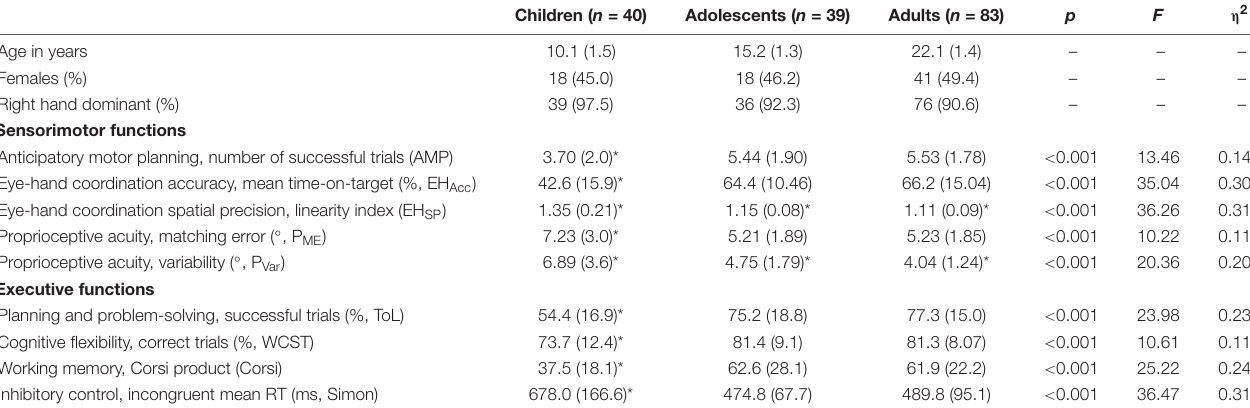
TABLE 1 | Demographic characteristics, descriptive statistics on raw data [means and standard deviation (in parentheses)], as well as results of one way ANOVAs (on the normalized data) used to examine differences in sensorimotor and cognitive functioning between children, adolescents, and young